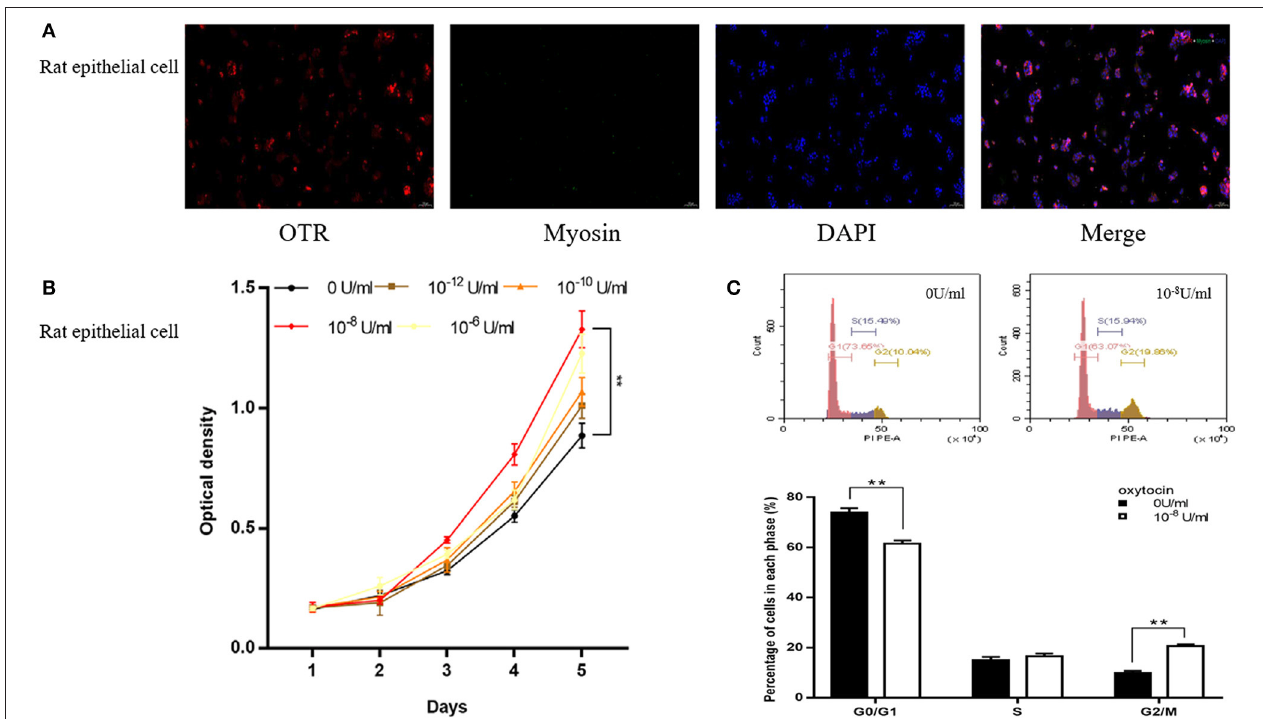
FIGURE 6 | Immunofluorescence, cell proliferation and Flow Cytometry of rat primary epithelial cell. (A) Immunofluorescence of rat primary epithelial cell. Cy3-immunofluorescence (red) indicates OTR expression. FITC-immunofluorescence (green) indicates MHC expression. DAPI (blue) indicates cell nuclear staining. Merged image indicates of OTR and DAPI. (B) Cell proliferation of prostate epithelial cells treated with OT. X-axis is culture time and Y-axis is OD. (C) Flow Cytometry analyzing the cell cycle of rat epithelial cell treated with OT. Upper: Flow Cytometry analyses for cell cycle in rat epithelial cells treated with selected concentration of OT at 0 and 10 − 8 U/ml. Lower: Bar graph for the percentage of rat epithelial cells in each cell phase. Cells cultured with 0 U/ml of OT are used as controls whereas cells cultured with other dosages of OT are the treatment groups. ** P < 0.01 vs.